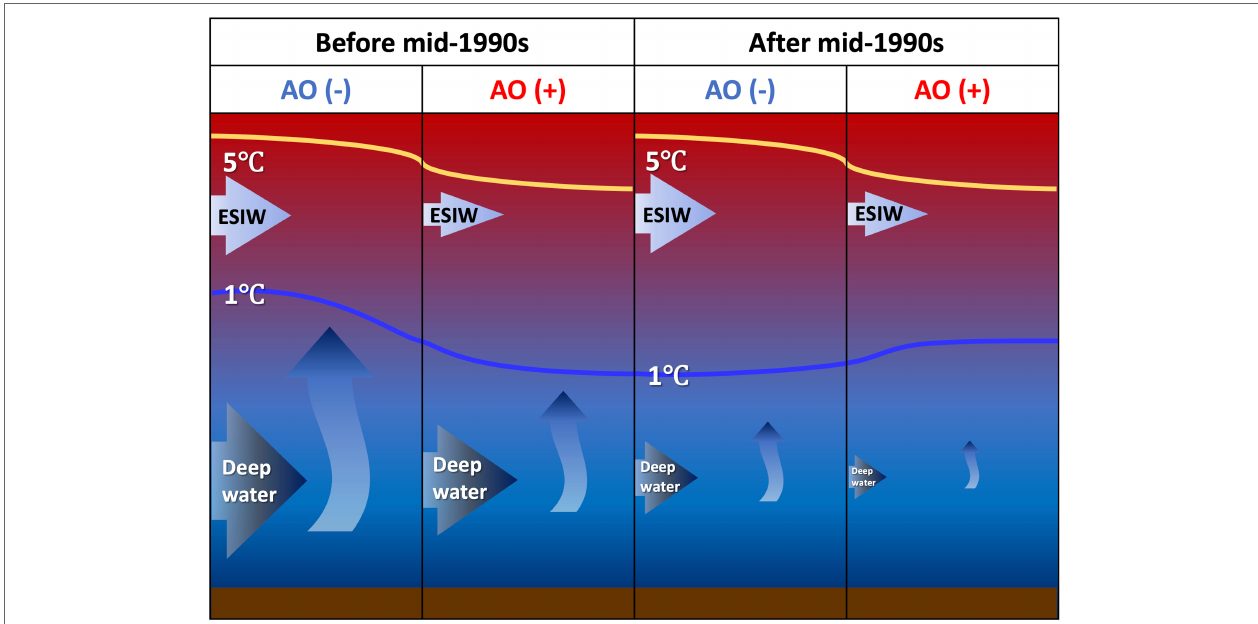
FIGURE 15 | Schematic of the working hypothesis for the ESIW thickness change in the framework of the East Sea Meridional Overturning Circulation